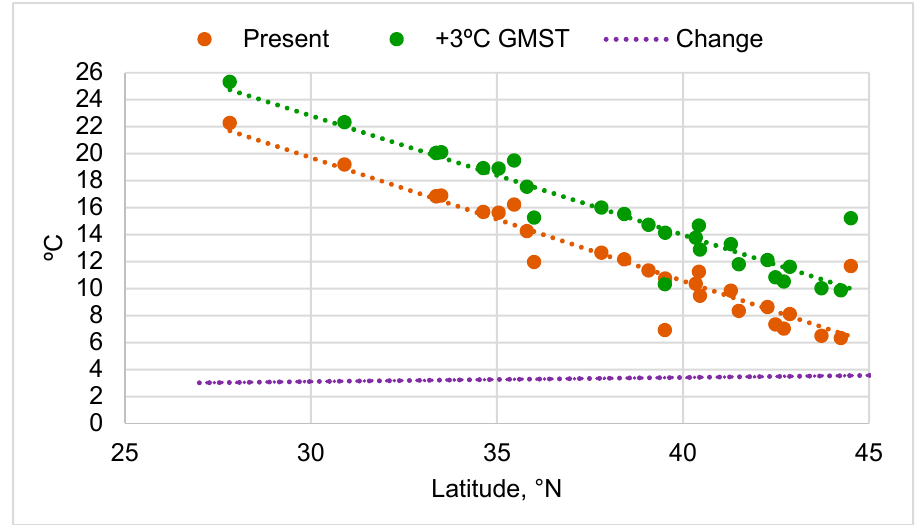
Figure 4. Average temperature versus population centroid latitude of the US states and state groups at Present (2009), at 3 ◦ C GMST increase, and the temperature change [IV]